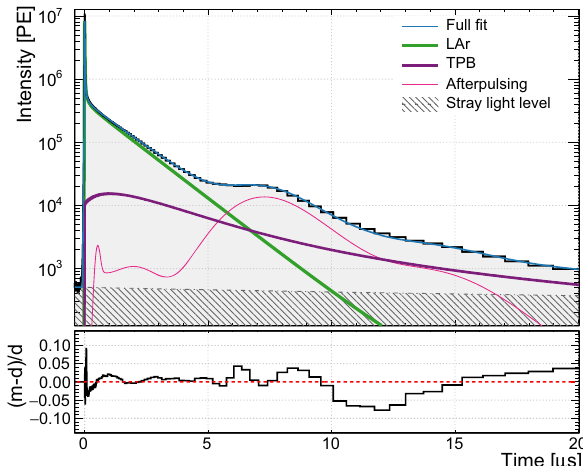
Fig. 6 From 0 . 2 µ s to 5 µ s, the pulseshape is dominated by the LAr scintillation light. The region from 5 µ s to 10 µ s is dominated by PMT afterpulsing.Startingatapproximately13 µ s,theTPBdelayedemission becomessignificant.WhilethetotaleventlengthinstandardDEAPdata is 16 µ s, the analysis window on which PSD as well as event energy and position reconstruction is based is − 0 . 03 µ s to 10 µ s with respect to the event peak